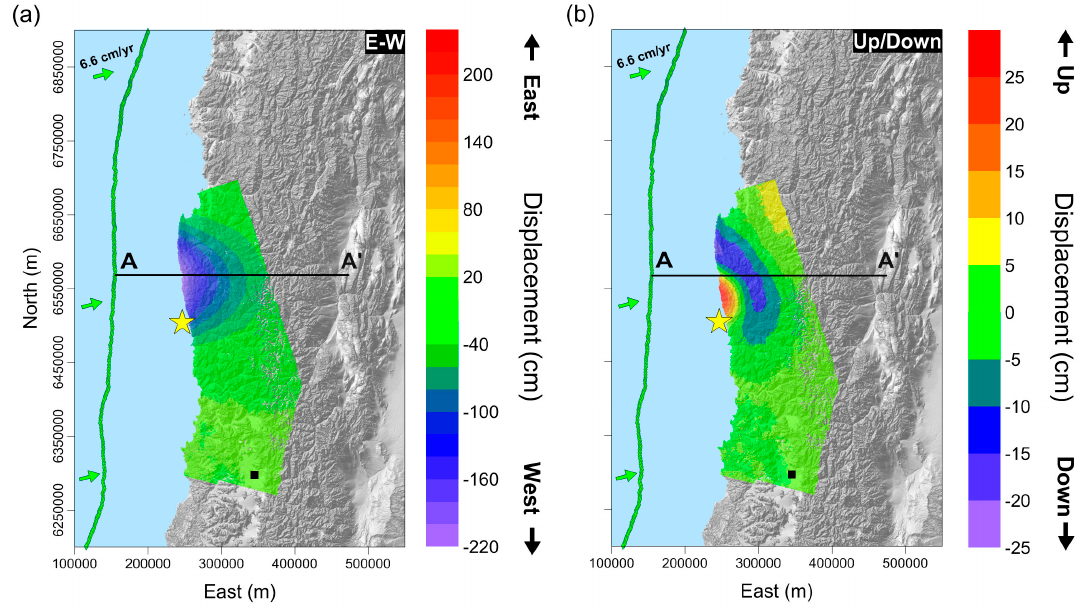
Figure 3. Displacement components computed from the descending and ascending displacement maps shown in Figure 2a,b, respectively, for the pixels that are common to both maps; ( a ) east–west deformation component; ( b ) vertical deformation component. The pixel identified by the black square represents the reference point of the common mask. AA’ line is the trace of the SAR data profile used for the 2D Finite Element (FE) modeling.